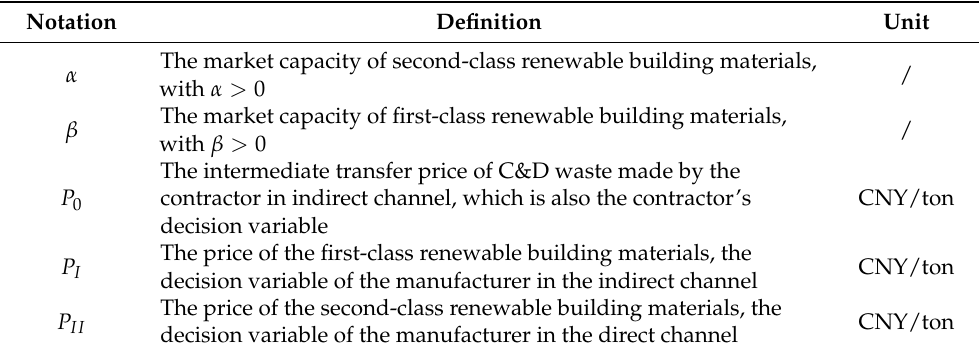
Table 1. Notation and